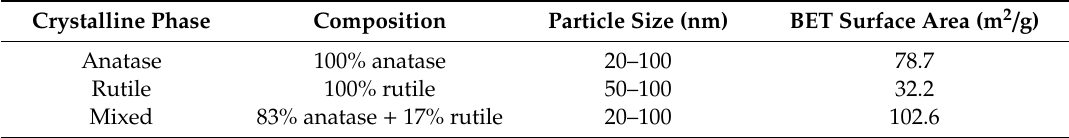
Table 2. Characteristics of nano-TiO 2